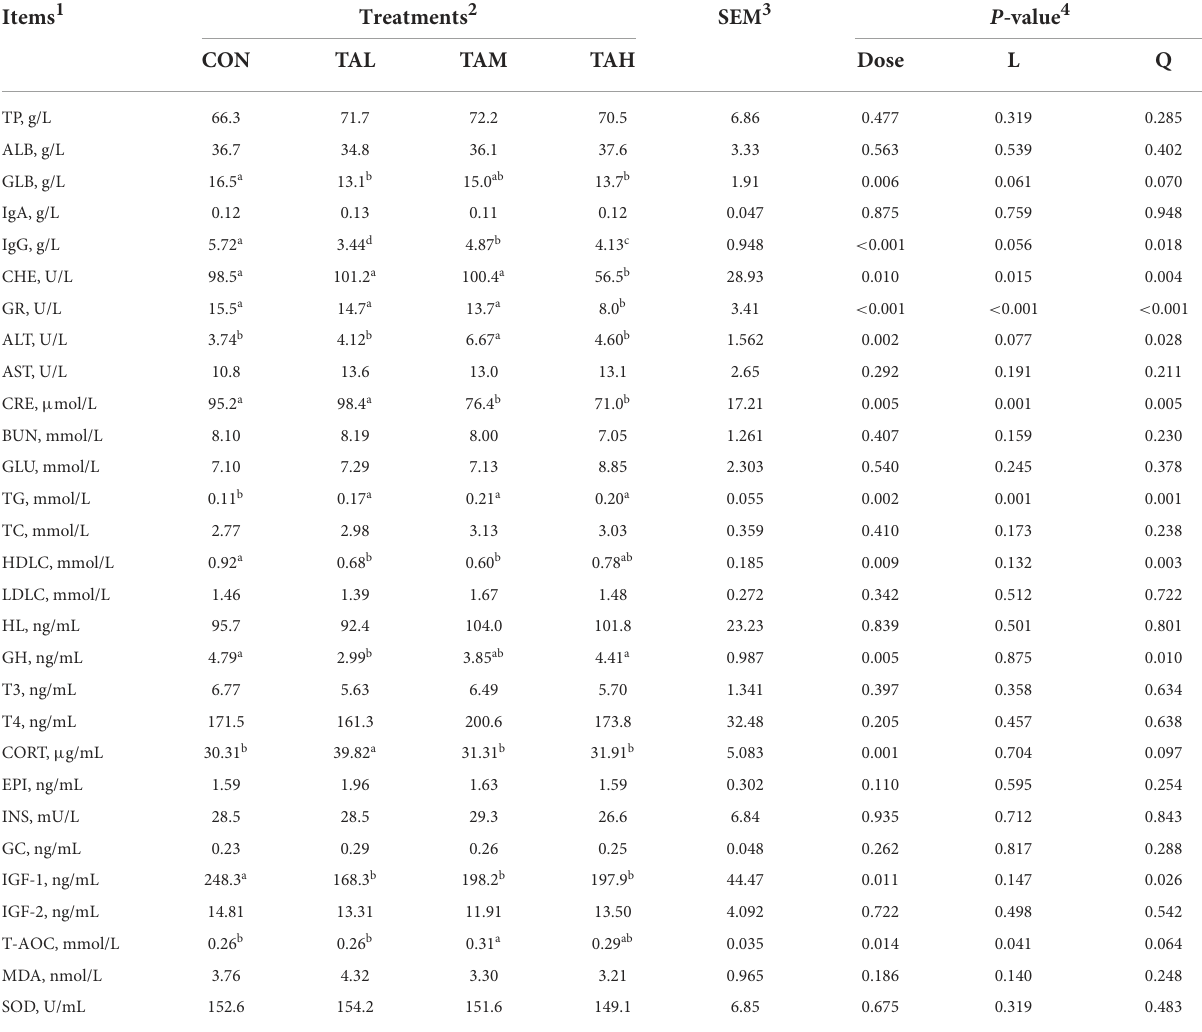
TABLE 4 Effects of tannic acid at different doses on biochemical and physiological parameters in the blood serum of black goats. Items 1 Treatments